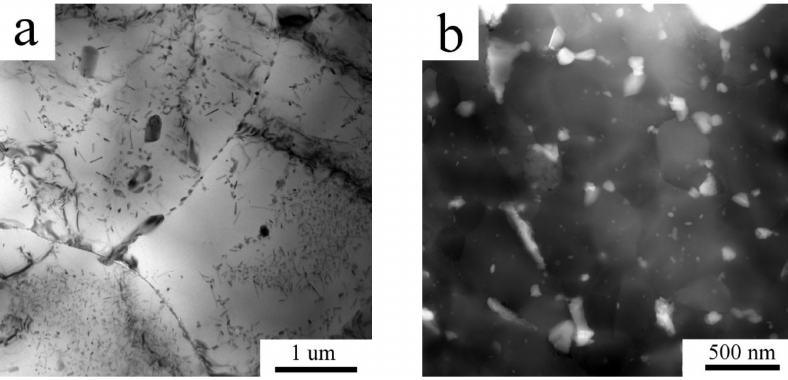
Figure 15. The microstructure of the compacts annealed 425 ◦ C/1 h: ( a ) Al7075_AC_HT, TEM; ( b ) Al7075_MC_HT, STEM.